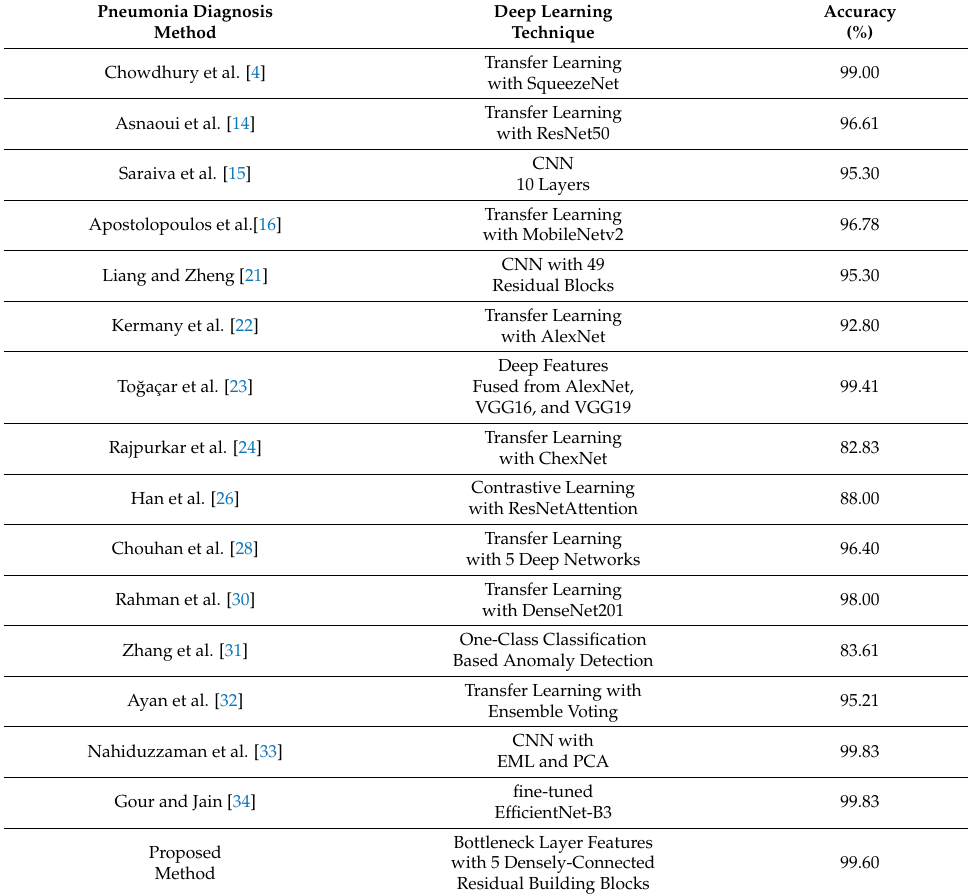
Table 4. Comparison of proposed pneumonia diagnosis system with recent state-of-the-art